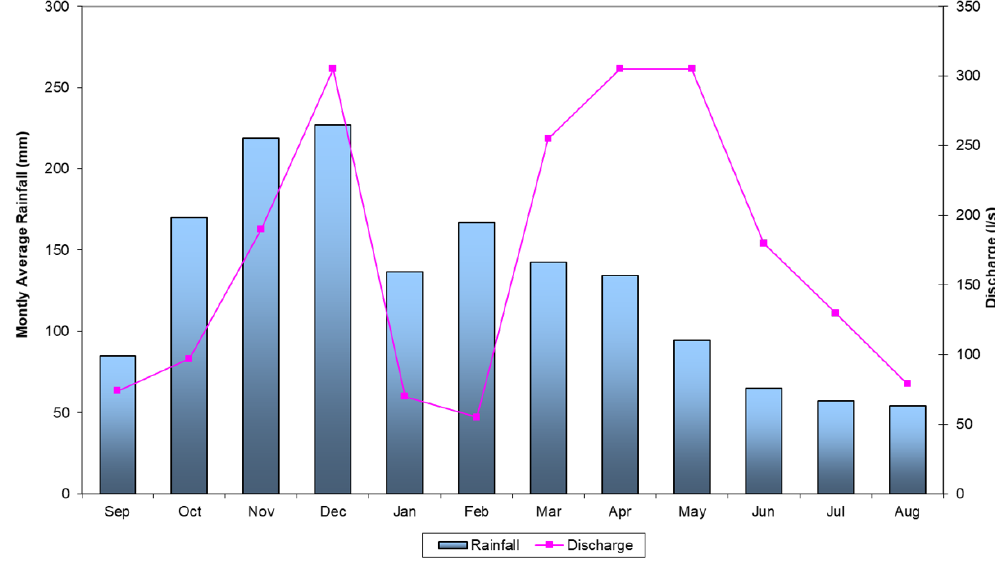
Figure 3. Monthly average rainfall and Carpinetto spring (GW6), average rate.